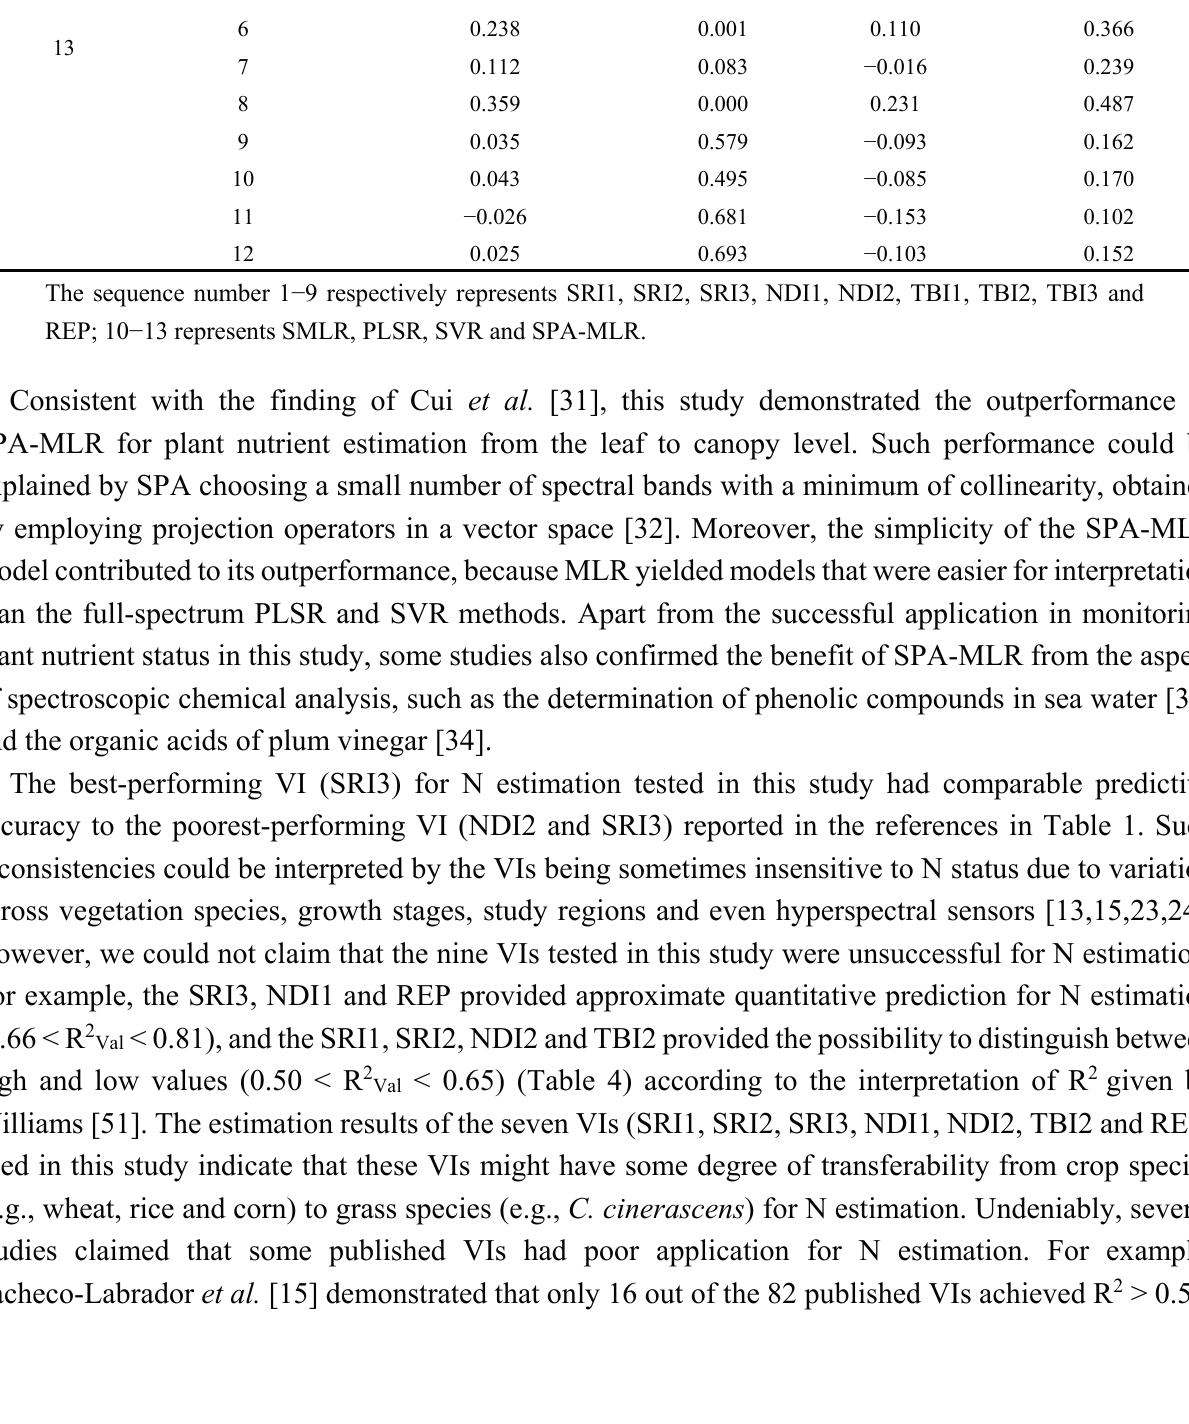
Table 6. One-way analysis of variance (ANOVA) of the R 2 Val values between SPA-MLR and the other 12 modeling methods in N and P estimations. Model Sequence Number Mean Difference (I − J)